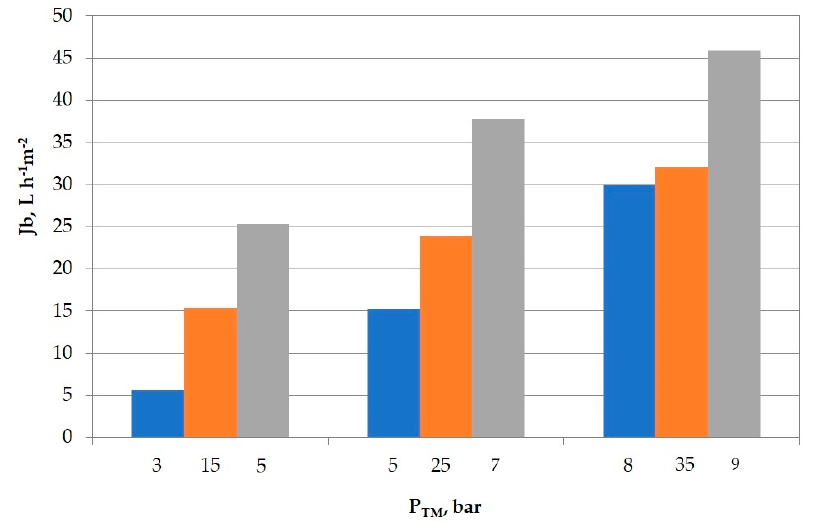
Figure 1. Boundary flux (J b , L · h − 1 · m − 2 ) measured as a function of the applied transmembrane pressure (P TM , bar) for the three membranes tested: RO-AK (blue), RO-SC (orange), and NF-DK (grey). Operating conditions: 22 °C, 5.1 m/s, volume recovery factor (VRF) ≥ 90%.